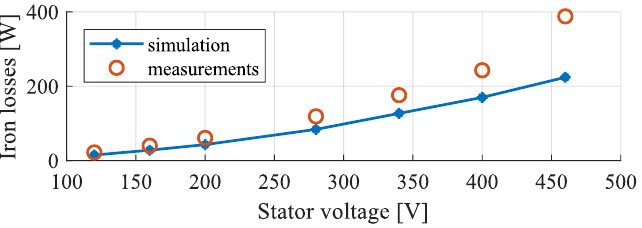
Figure 17. First comparison between measurements and simulation in the no-load test of the 11kW machine. The measurements have been done according to the standard, increasing the stator voltage from 30% to 115% of the rated